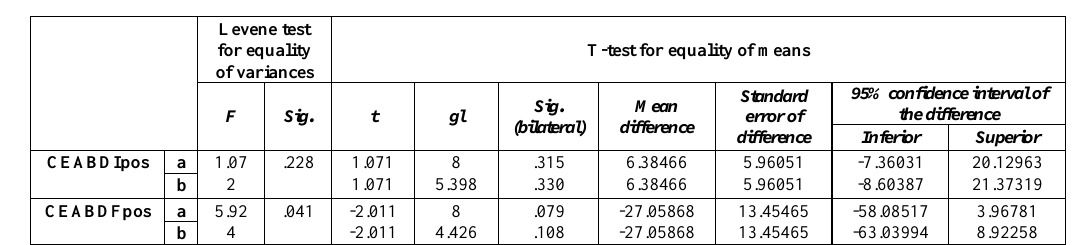
T-test for equality of means 95% confidence interval of Standard Sig. Mean the difference error of (bilateral) difference difference Inferior Superior